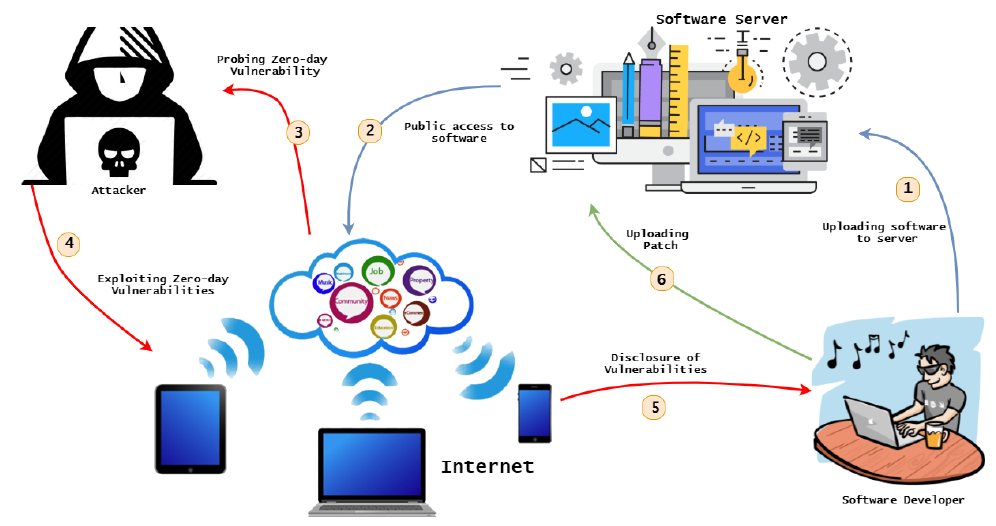
Figure 1. Zero-day real-life